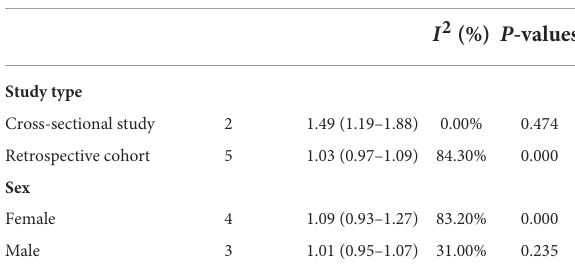
TABLE 2 Subgroup analysis for the risk of dementia or cognitive impairment in patients with